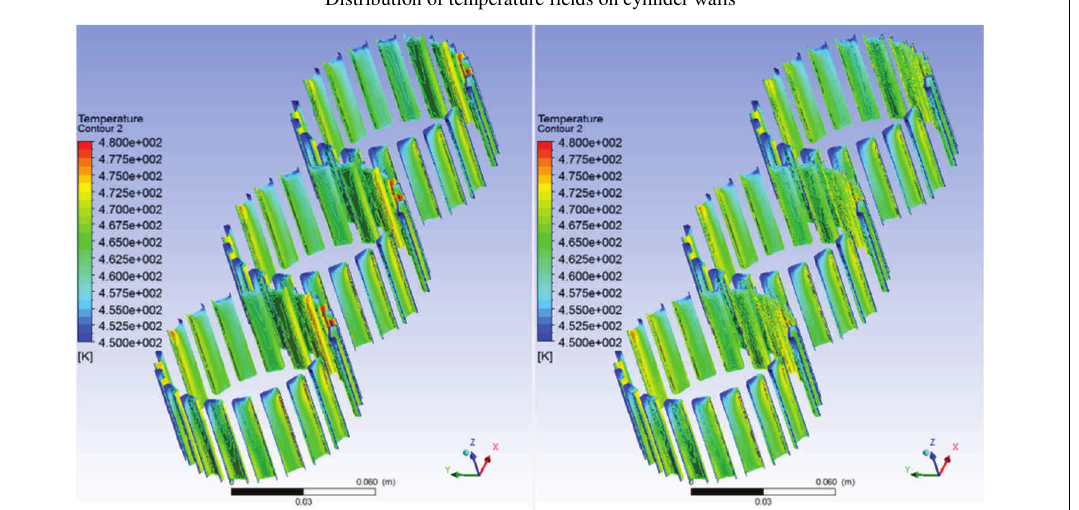
Fig. 16. Comparison of the distribution of velocity fields across the ribs and the temperature fields for the model with reduction of flow